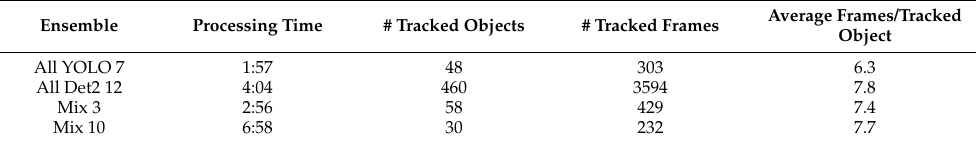
Table 4. Processing metrics for selected ensemble